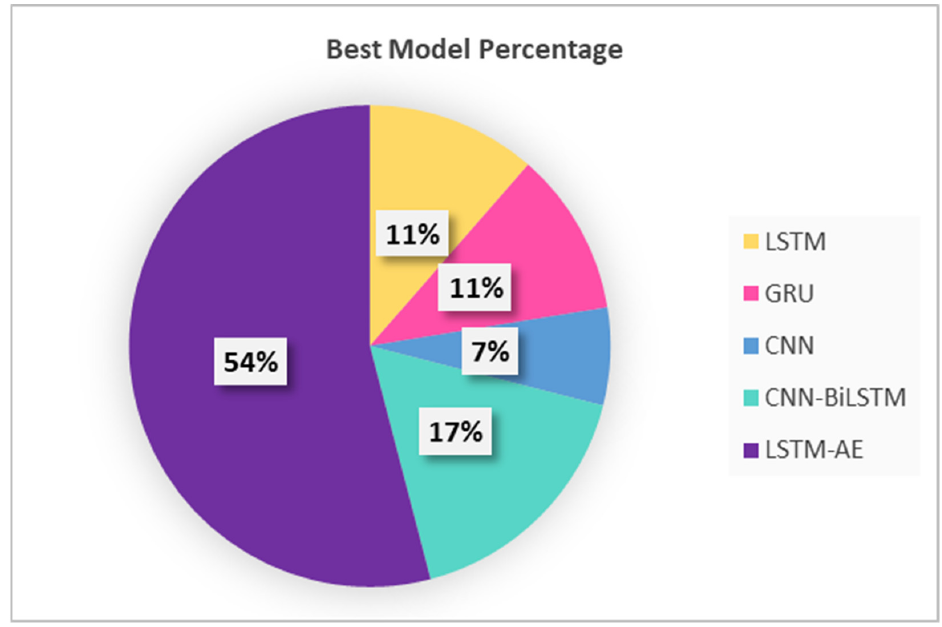
Figure 31. The achieved percentage of the models as “best model” based on the forecasting error.